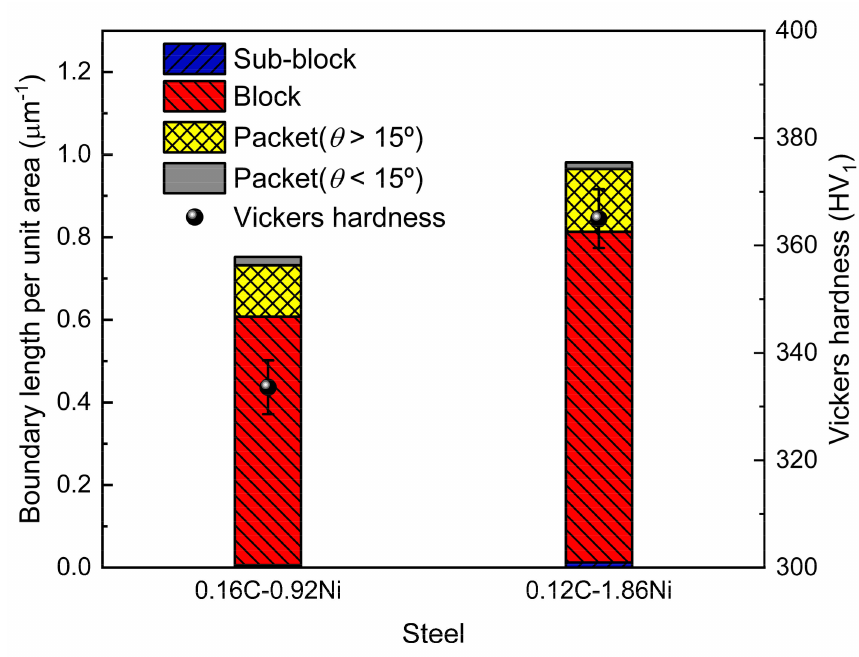
Figure 7. Boundary density and Vickers hardness of the steels cooled at 0.5 ◦